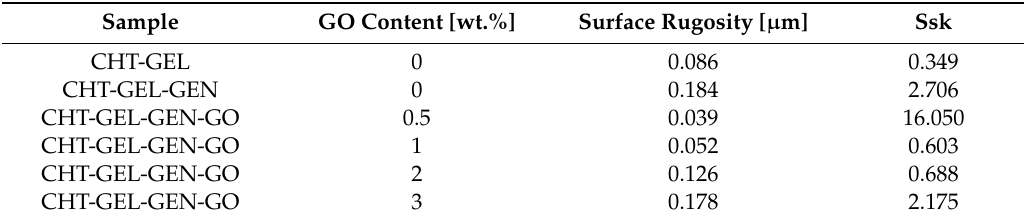
Table 2. Height distribution skewness (Ssk) of composite and control film.